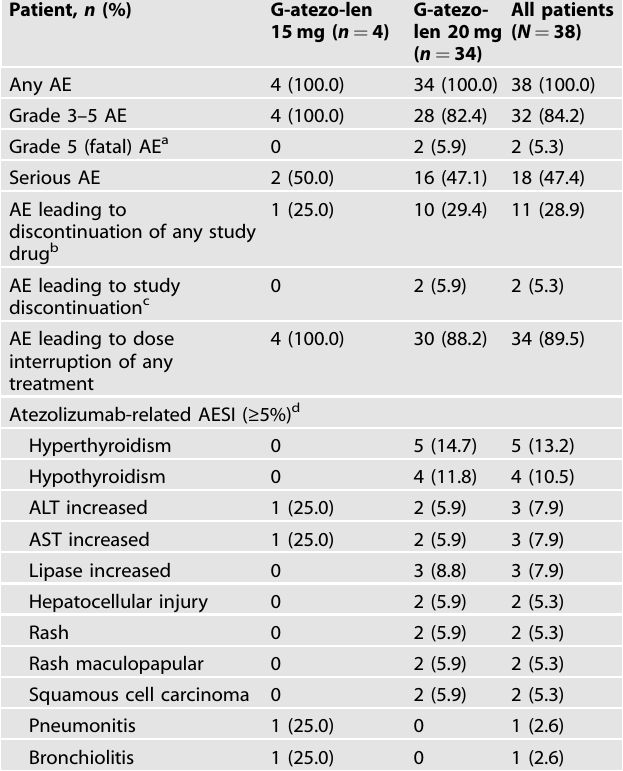
Table 3. Summary of adverse events ( fi nal